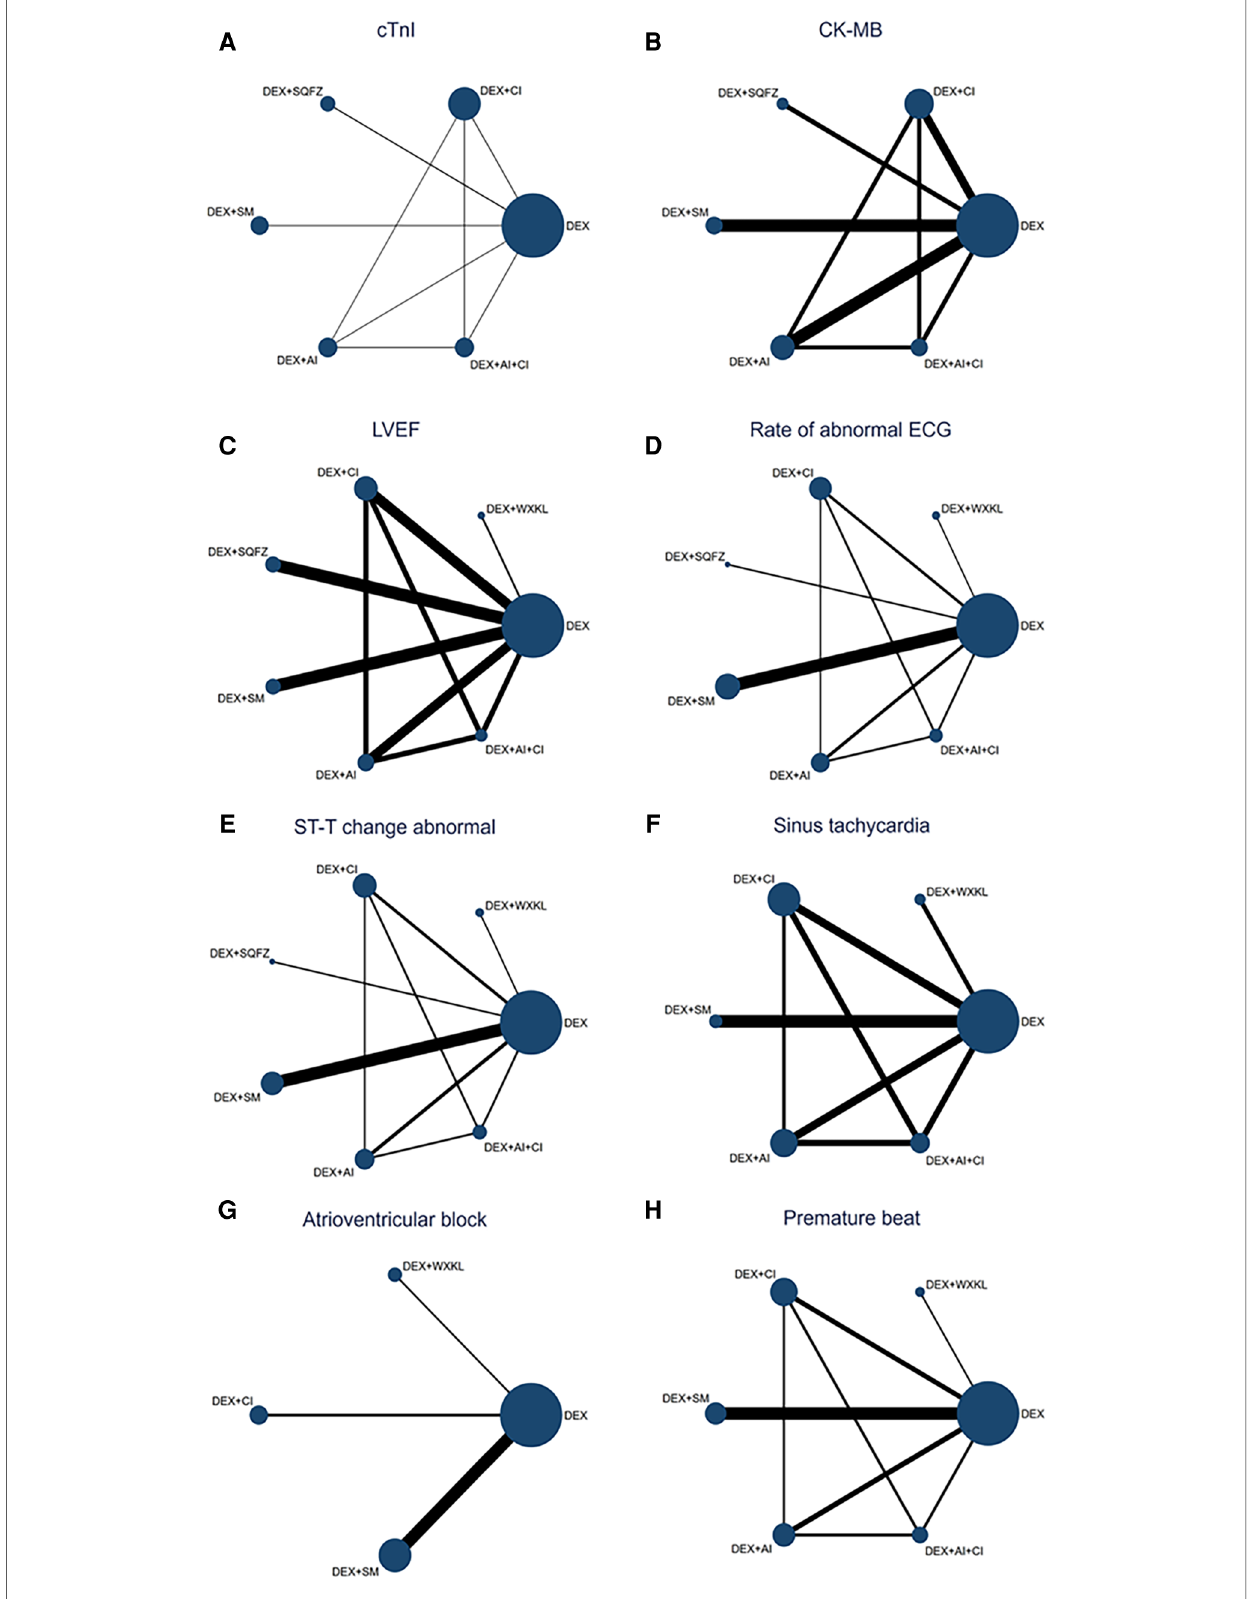
FIGURE 3 Network map for all outcomes. ( A ) cTnI. ( B ) CK-MB. ( C ) LVEF. ( D ) Rate of abnormal of ECG. ( E ) ST-T change abnormal. ( F ) Sinus tachycardia. ( G ) Atrioventricular block. ( H ) Premature beat. (DEX, Dexrazoxane; DEX+WXKL, Dexrazoxane combined with Wenxinkeli; DEX+CI, Dexrazoxane combined with Cinobufotalin injection; DEX+SQFZ, Dexrazoxane combined with Shenqifuzheng injection; DEX+SM, Dexrazoxane combined with Shenmai injection; DEX+AI, Dexrazoxane combined with Astragalus injection; DEX+AI+CI, Dexrazoxane combined with Astragalus with Cinobufotalin injection). The size of every node is proportional to the number of participants (sample size). Lines represent the available direct comparisons between pairs of treatments. Their width is proportional to the number of trials comparing every pair of